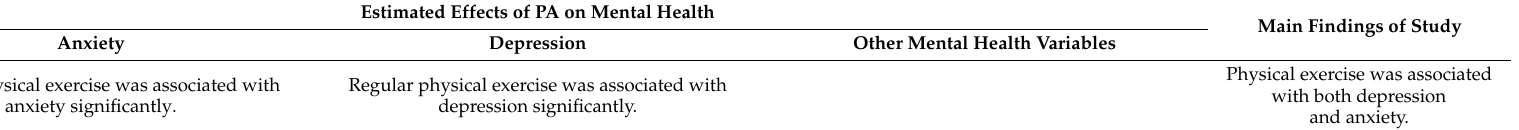
Table 3. Estimated effects of physical activity on mental health in the studies included in the